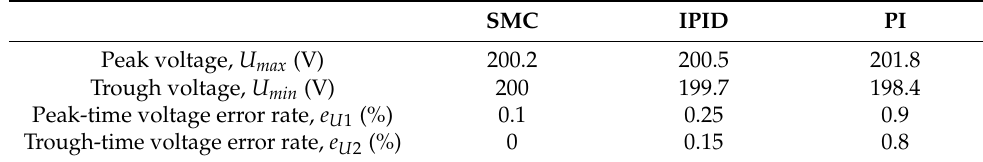
Table 3. Comparison of SMC, IPID and PI with continuous load